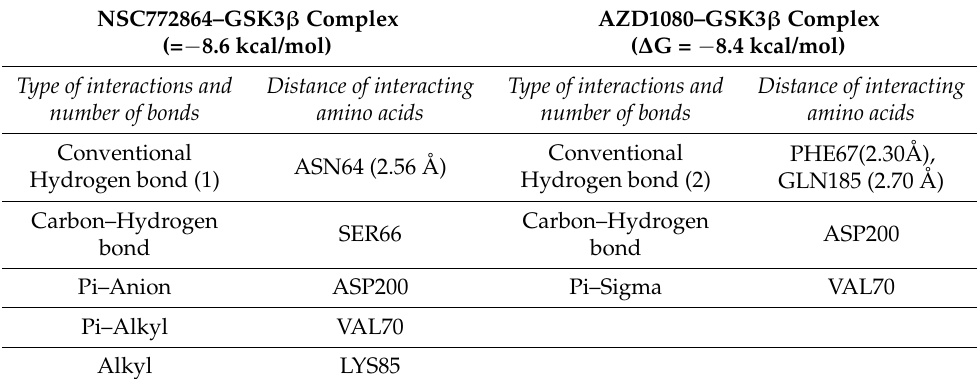
Table 4. NSC772864 and standard drug comparative docking profiles against GSK3 β .